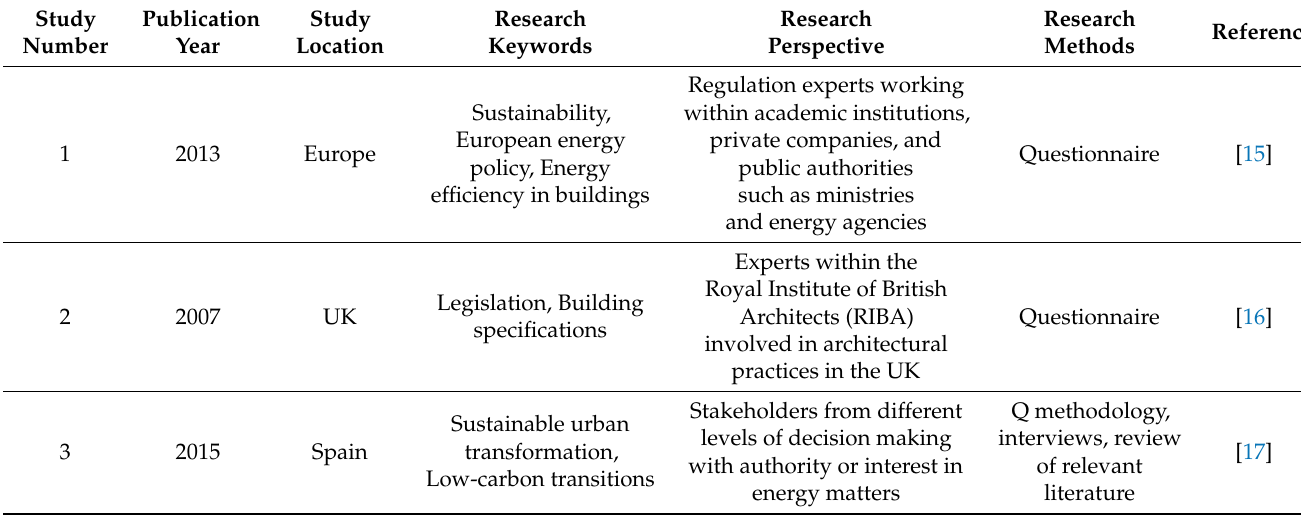
Table 1. Summary list of studies included in the literature